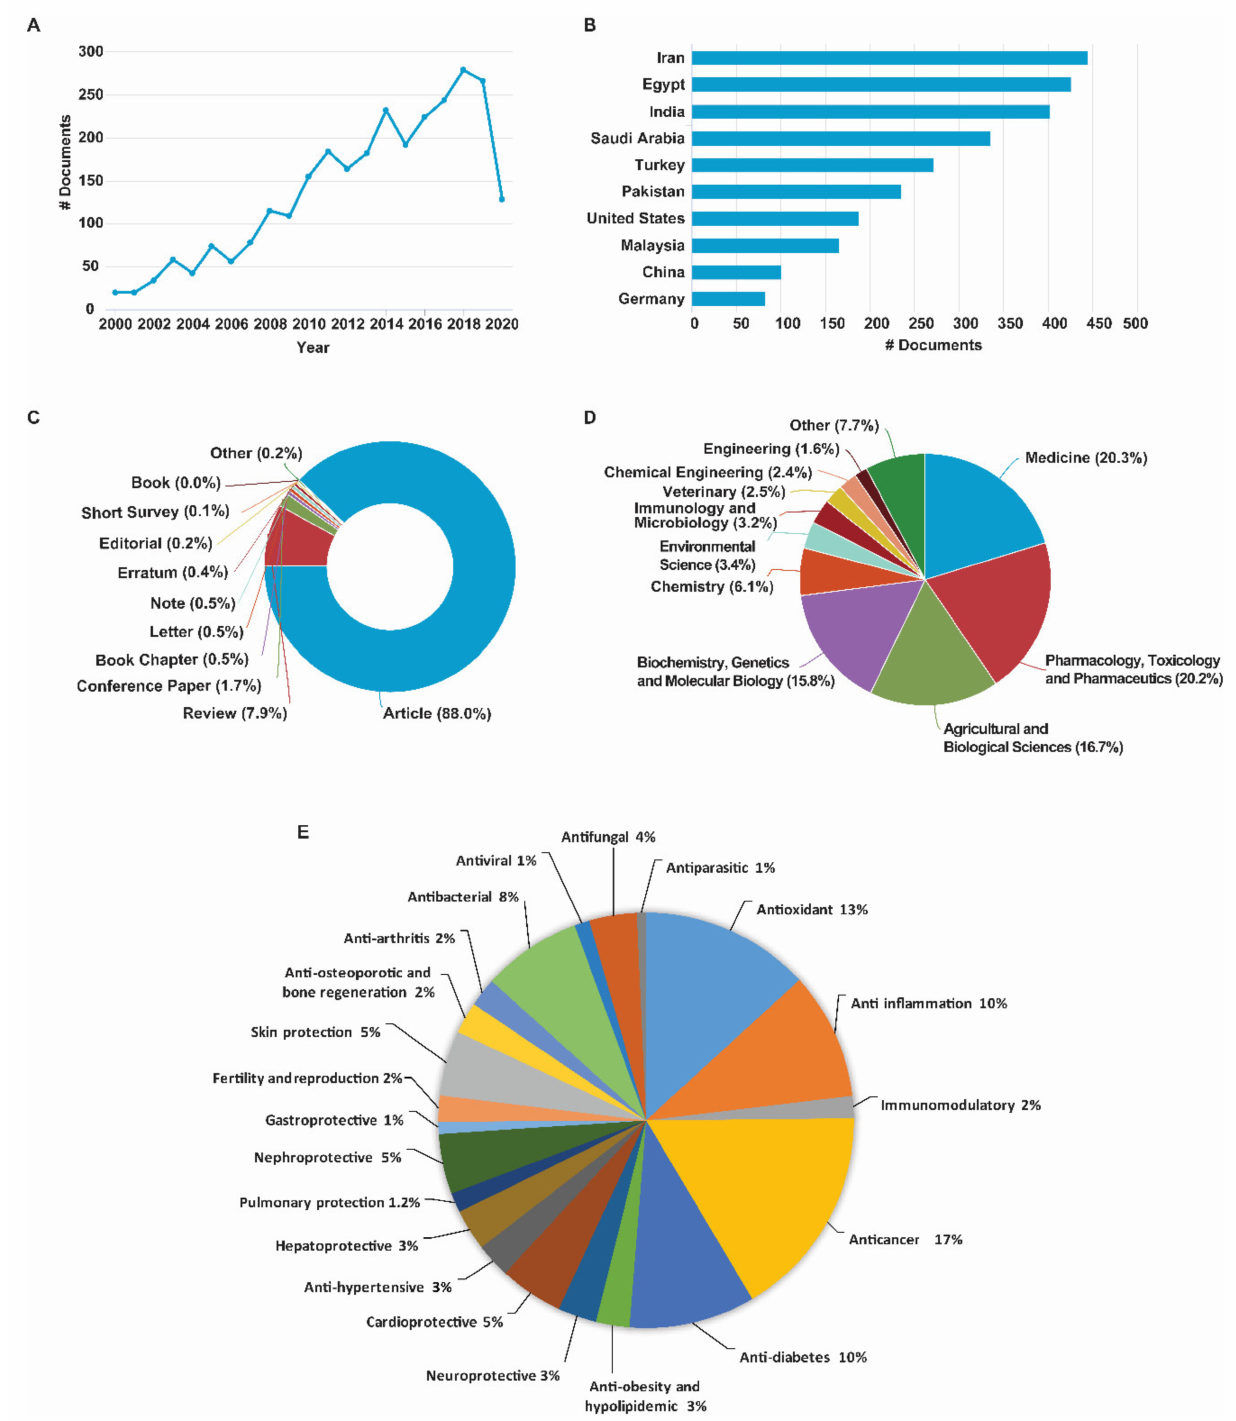
Figure 1. Research trends in black cumin. ( A ) Yearly appearance of publications. ( B ) Top 10 countries with the highest number of publications. ( C ) Document-wise proportional rate of publications. ( D ) Proportional rate of publications according to research areas. ( E ) Proportional rate of publications according to pharmacological effects. The data were retrieved from the Scopus database in June